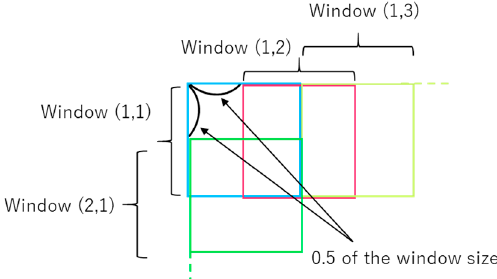
Figure 3 . How sliding windows are spaced in an image.